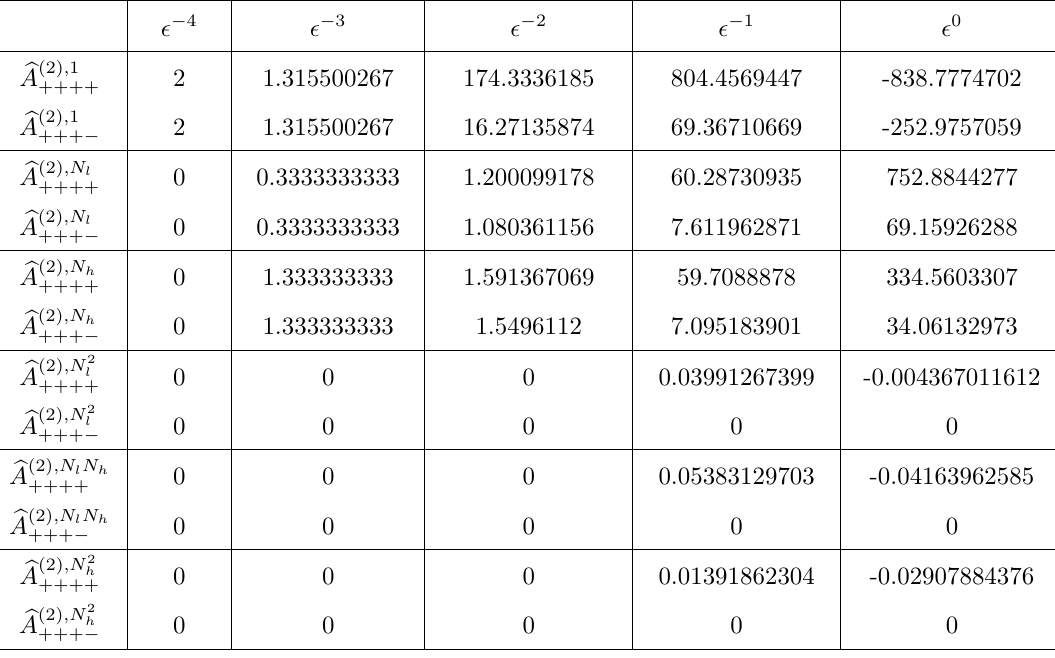
Table 1. Mass renormalised two-loop amplitudes (normalised to the tree level amplitude) using the kinematic point in eq.